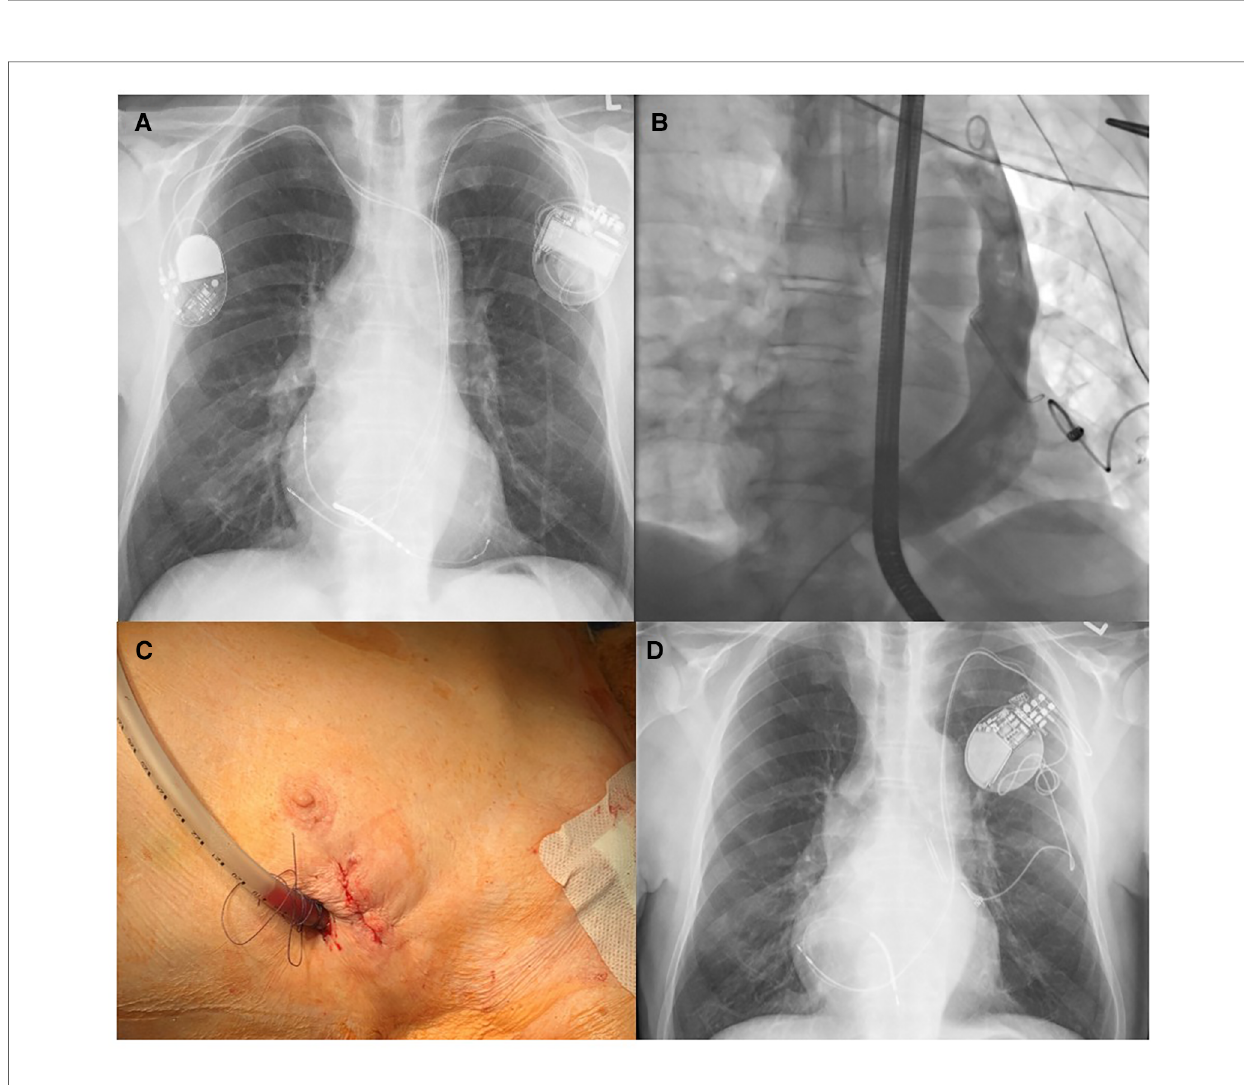
FIGURE 3 ( A ) Preoperative chest x-ray showing the left-sided CRT-D device and the right-sided pacemaker through left-sided superior vena cava (SVC). ( B ) Intraoperative venography, after extraction of all leads, displaying the left-sided SVC and the epicardial LV-lead as well as the AtriClip ® . ( C ) Minimally invasive left-lateral incision in the fourth intercostal space after wound closure. ( D ) Postoperative chest x-ray showing the AtriClip ® and the LV lead connected to a single-chamber